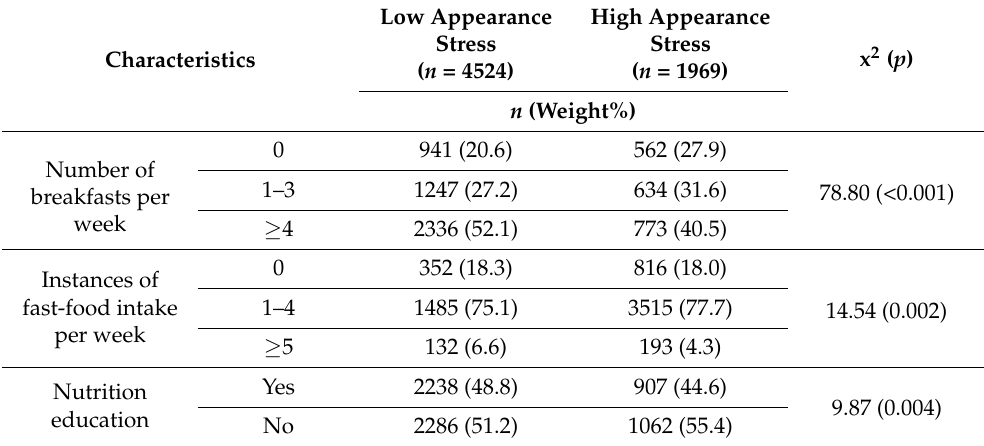
Table 2. Diet-related factors ( n = 6493).